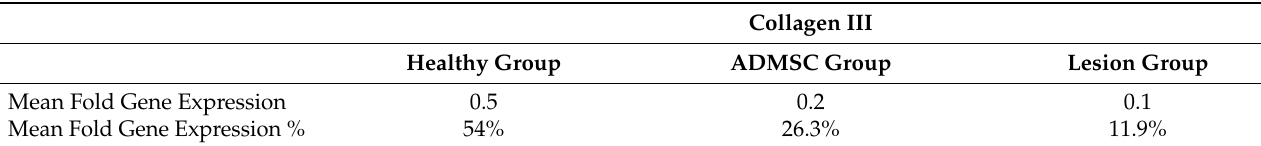
Table 3. Collagen III gene expression.